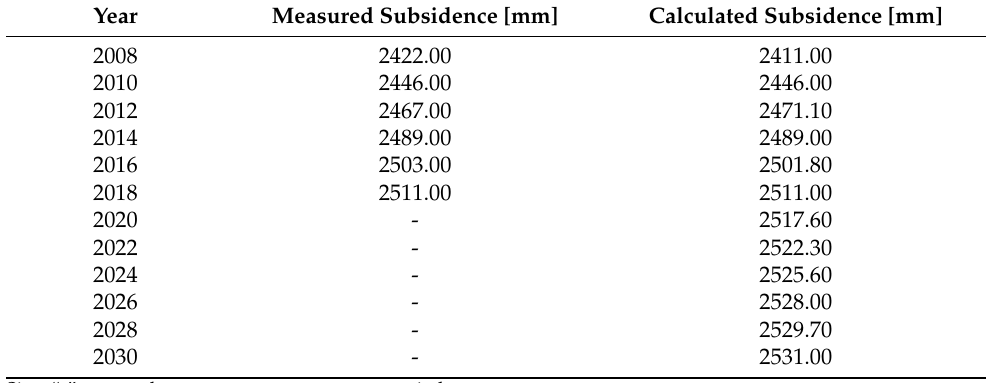
Table 5. Forecast of subsidence for point 4208900377 after completion of measurements in 2018.